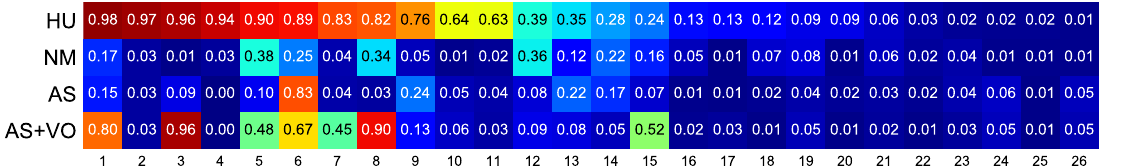
Figure 3. Heatmap of Phase Locking Index (PLI) for different participants (columns) in four conditions (rows). The number in a cell shows the PLI with the participant in each condition.